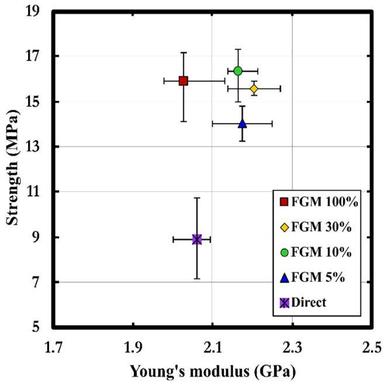
Variation of strength and Young's moduli of various interface design patterns.